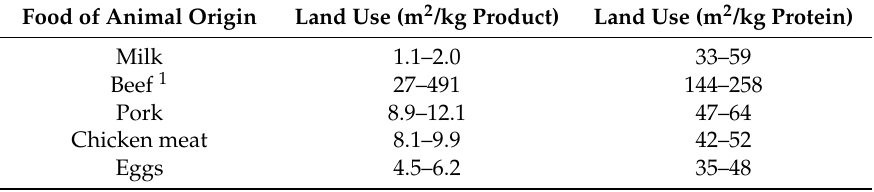
Table 7. Land use per livestock product or protein (in m 2 /kg product and m 2 /kg protein; n = 16;